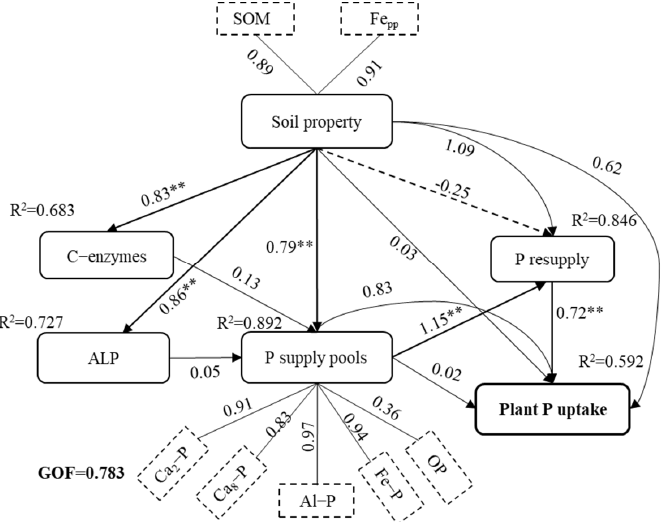
Figure 6. Partial least squares path model (PLS–PM) of the direct and indirect effects of the soil properties, C recycling enzymes, phosphatase and P fractions on plant P uptake. The observed variables are shown in the solid boxes. The numbers next to the single–headed arrows are the standardized path coefficients. The black solid and dashed line arrows represent negative and positive correlations, respectively. The value between the bold solid boxes is the correlation coefficient. The do tt ed boxes are the loadings of the latent variables. The goodness of fi t (GOF) value is calculated to evaluate the model. “**” indicates p <0.01.